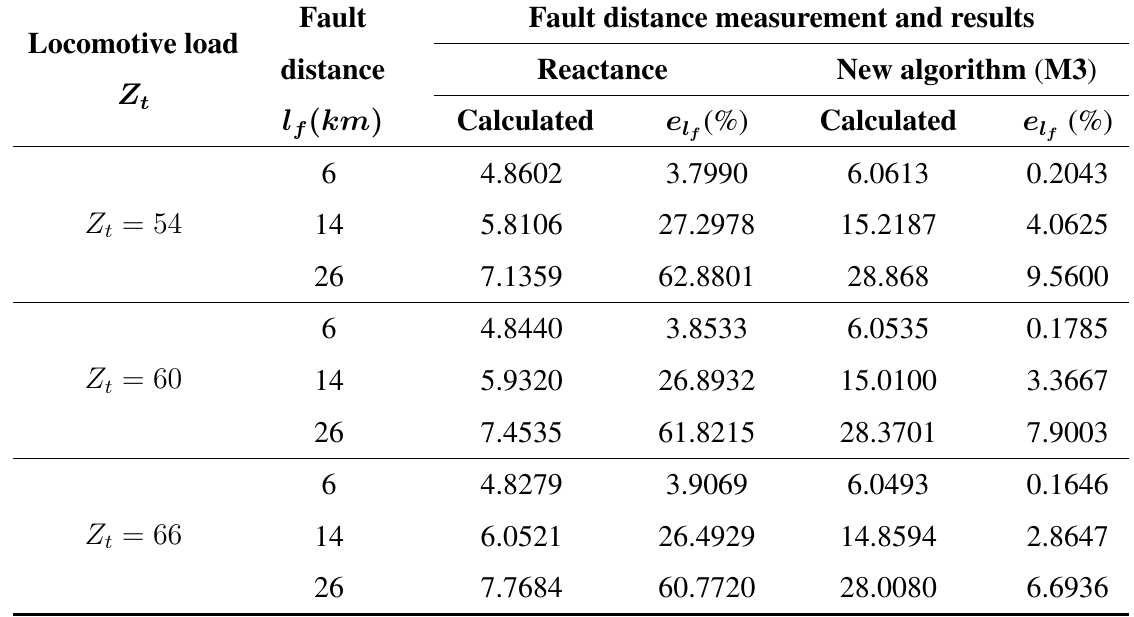
= 5 km, R = 100 Ω . t f